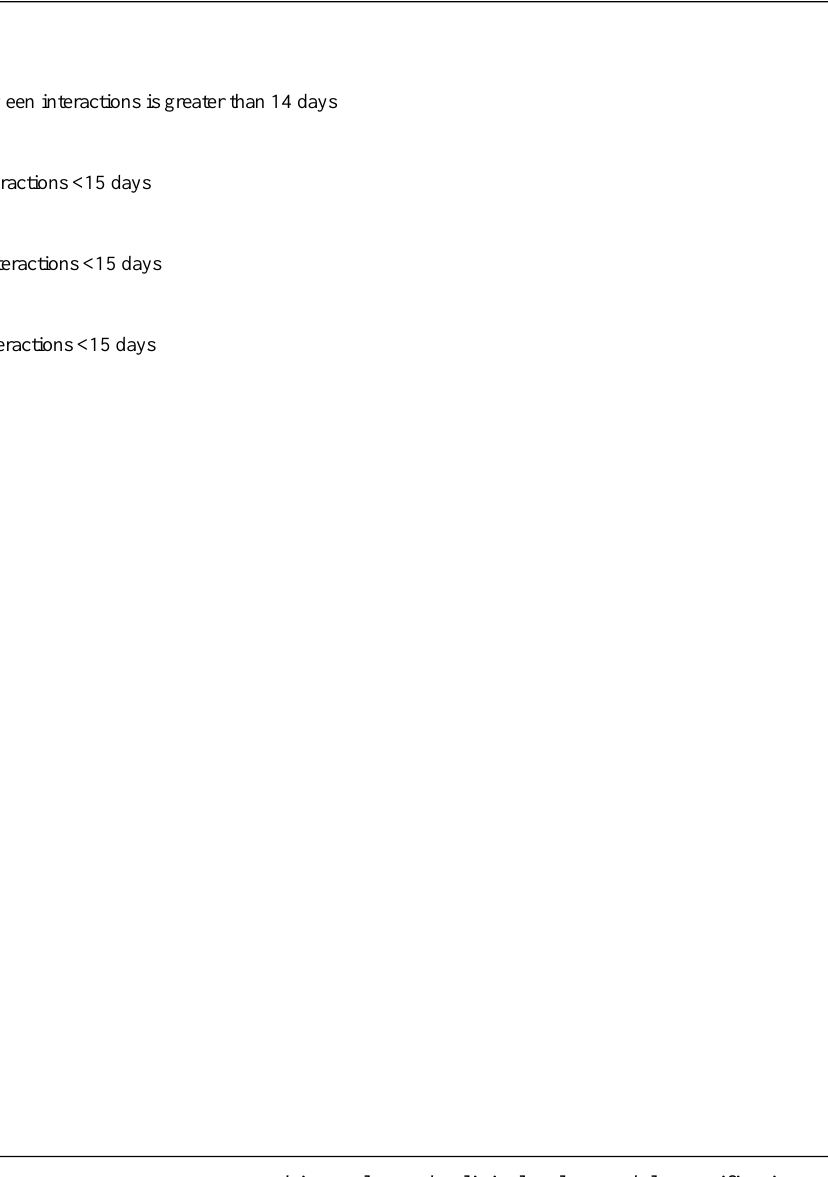
Textbox 1. Categorizations for different care modality